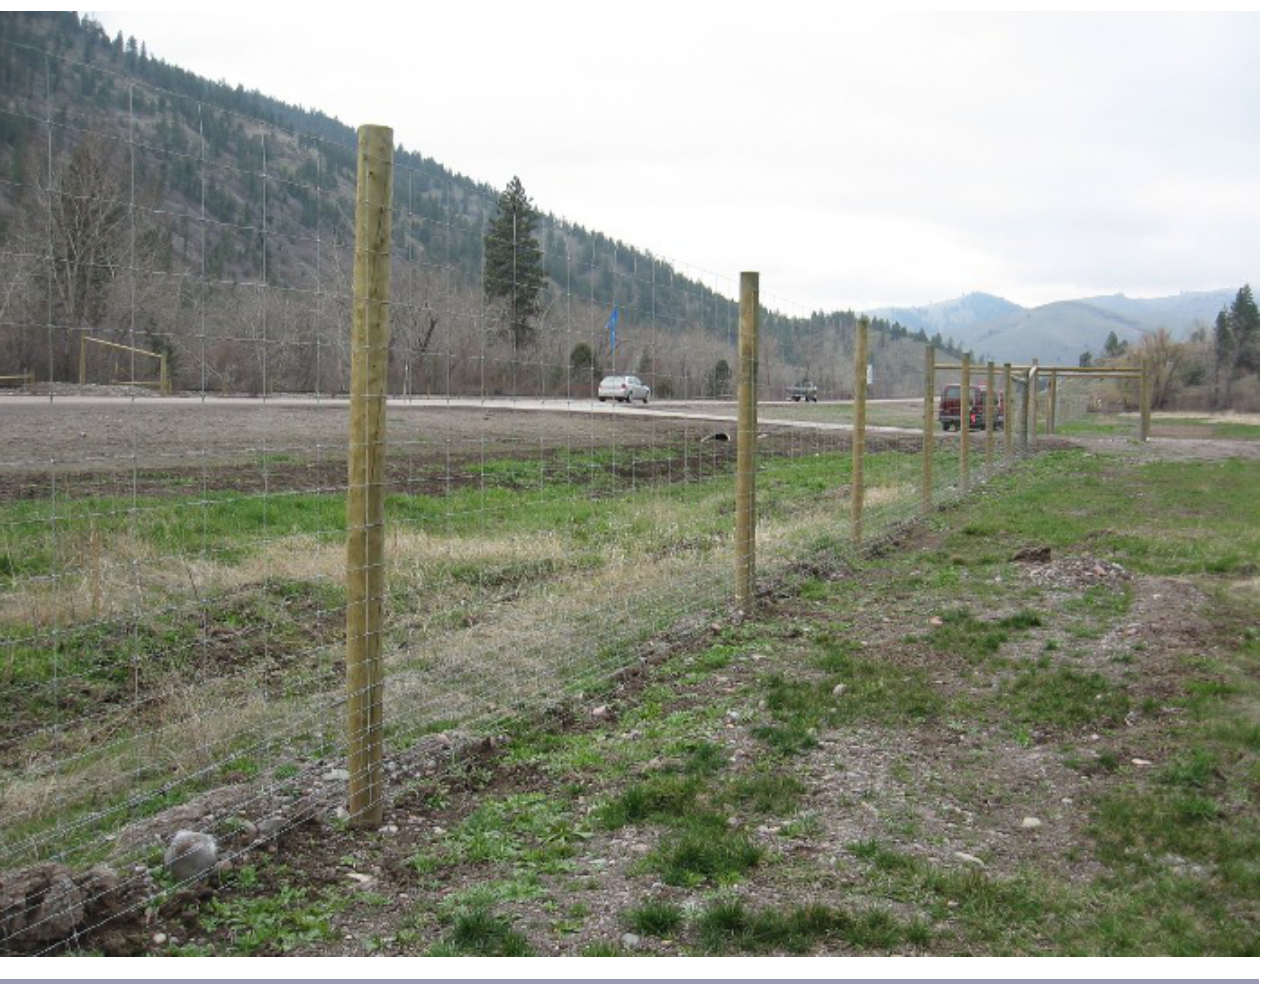
Fig. 1. A 2.4 m (8 ft) high large-mammal fence, with smaller mesh sizes toward the bottom, on U.S. Highway 93 on the Flathead Reservation, Montana, USA (copyright: Marcel